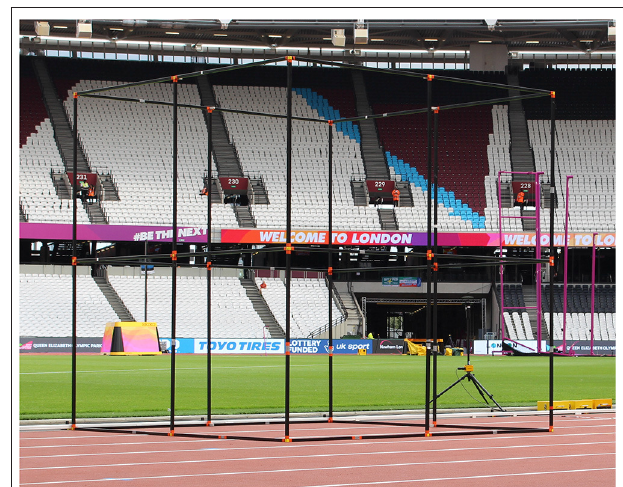
FIGURE 1 | Calibration frame used in the current study (3.044 m 3 ). The calibration frame pictured was placed at various locations across and